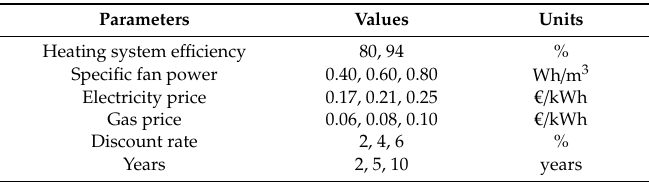
Table 4. Economic analysis input values.